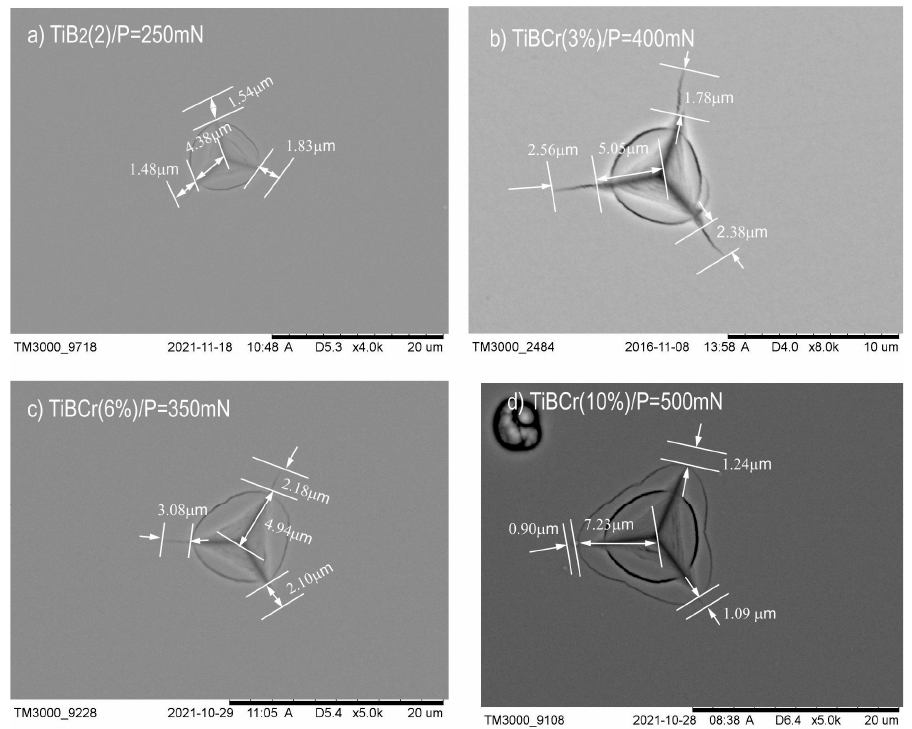
Figure 5. The SEM images of indentations for selected TiB 2 and TiBCr coatings after fracture toughness experiments with different values of applied loading force ( a ) TiB 2 (2), P critical = 250 mN; ( b ) TiBCr (3%), P critical = 400 mN; ( c ) TiBCr (6%), P critical = 350 mN and ( d ) TiBCr (10%), P critical = 500 mN.